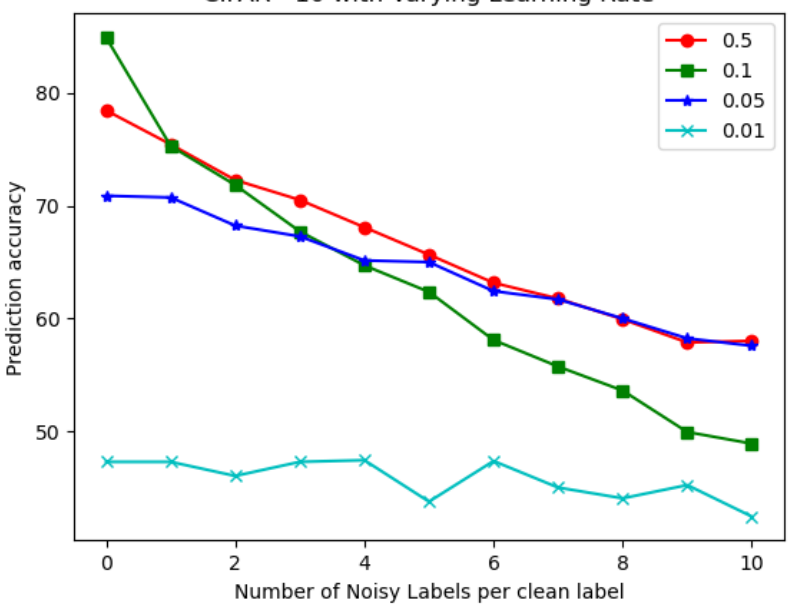
Figure 10. Variation in accuracy with respect to the LR in the CIFAR-10 for the QNN.